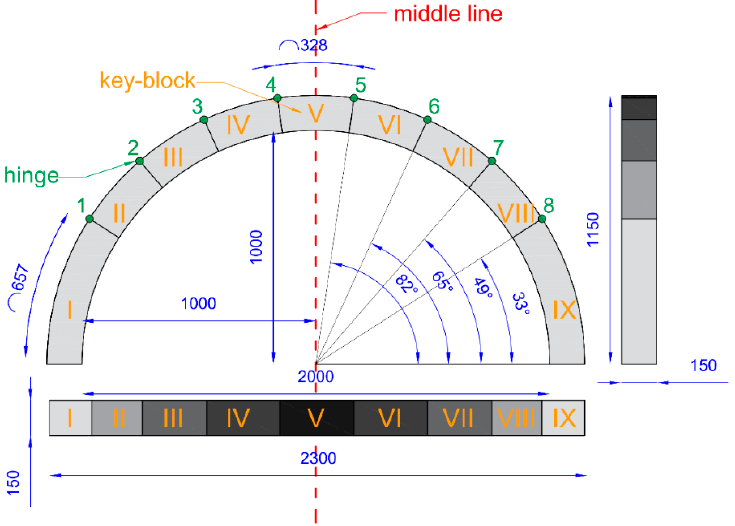
Figure 7. Prototype geometry ( dimensions in mm ).